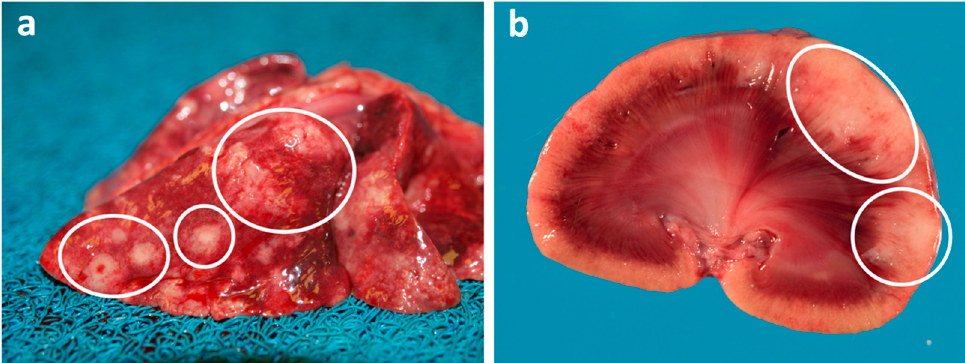
Figure 3. Macroscopic images of a metastatic mammary carcinoma in a cat. Postmortem examina- tion of a 6-year old female Domestic long hair cat with a mammary carcinoma that had metastasized to the ( a ) lung and ( b ) kidney. White circles show the tumours in each organ. Photos courtesy of Dr. Jeff Caswell (Department of Pathobiology, University of Guelph).